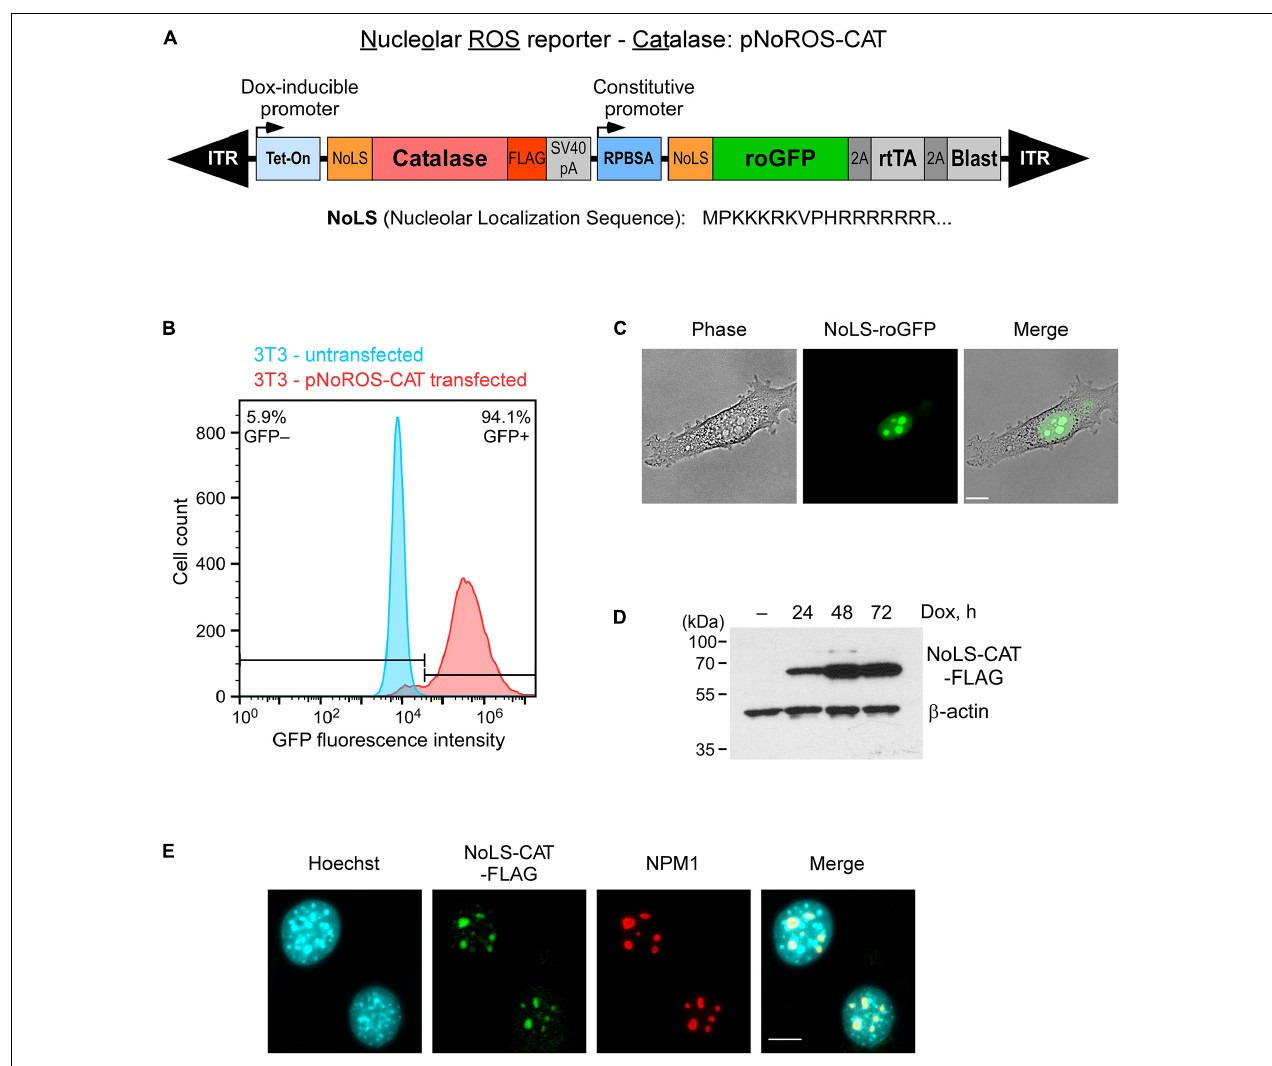
FIGURE 1 | Targeting of roGFP and catalase to the nucleolus. (A) Schematic of the genome-integrated portion of pNoROS-CAT flanked by inverted terminal repeats (ITR). The Dox-inducible Tet-On promoter controls expression of a mouse catalase gene fused with a nucleolar localization sequence (NoLS) at the N terminus and a FLAG tag at the C terminus of the protein. The constitutive RPBSA promotor drives expression of a polycistronic sequence encoding NoLS-roGFP, tetracycline transactivator gene (rtTA), and blasticidin resistance marker, all separated by 2A self-cleaving peptide elements. (B) Flow cytometric analysis of a pool of 3T3 cells transfected with pNoROS-CAT following a single round of blasticidin selection. (C) Phase-contrast and fluorescent live imaging of cells from a pNoROS-CAT-transfected cell pool shows NoLS-roGFP accumulation in the nucleolus. (D) Western blot of NoLS-CAT induction in cells stably transfected with pNoROS-CAT. NoLS-CAT was detected with FLAG antibody, endogenous β -actin is a loading control. (E) Immunofluorescent analysis shows NoLS-CAT targeting to the nucleolus. NoLS-CAT was detected using FLAG antibody, the nucleolus was visualized with antibody against endogenous NPM1. Nuclei were counterstained with Hoechst 33342. In (C,E) , representative microscopic fields are shown. Scale bars, 10 µ